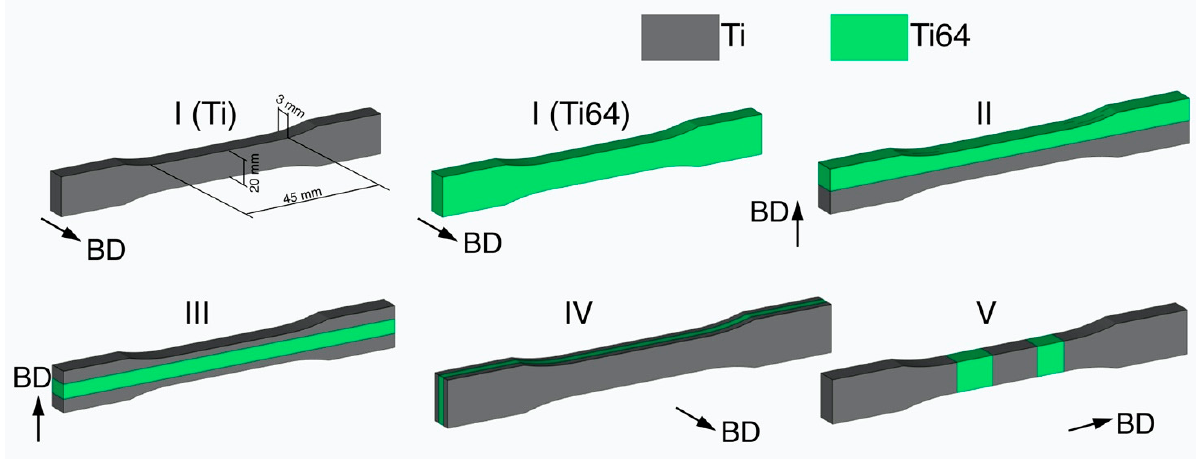
Figure 2. Schematic representation of tensile specimens’ configuration. Specimens consisting entirely of Ti of Ti64 materials were labeled as I (Ti) and I (Ti64), respectively. The remaining specimens consisting of two materials are shown in Figure 2. Type II specimens were split in half and consisted of 50% Ti and 50% Ti64 materials. Type orientations of the insert with 50%/50% volume fraction of the alloys. The IV type specimen had two inserts from Ti64 alloy as shown in Figure